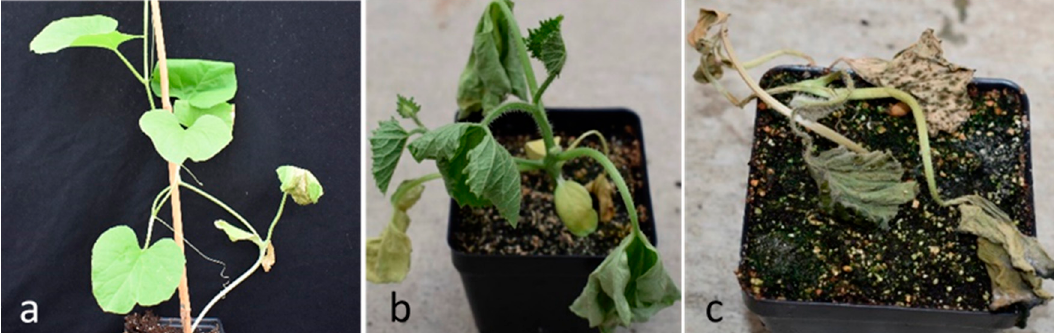
Figure 1. Development of symptoms of bacteria wilt in melon. Days to wilting of inoculated leaf (DWIL), symptom: Only the inoculated leaf wilts ( a ), days to wilting of whole plant (DWWP), symptom: the whole plant wilts ( b ), days to death of whole plant (DDP), symptom: whole plant wilts and dries ( c ).